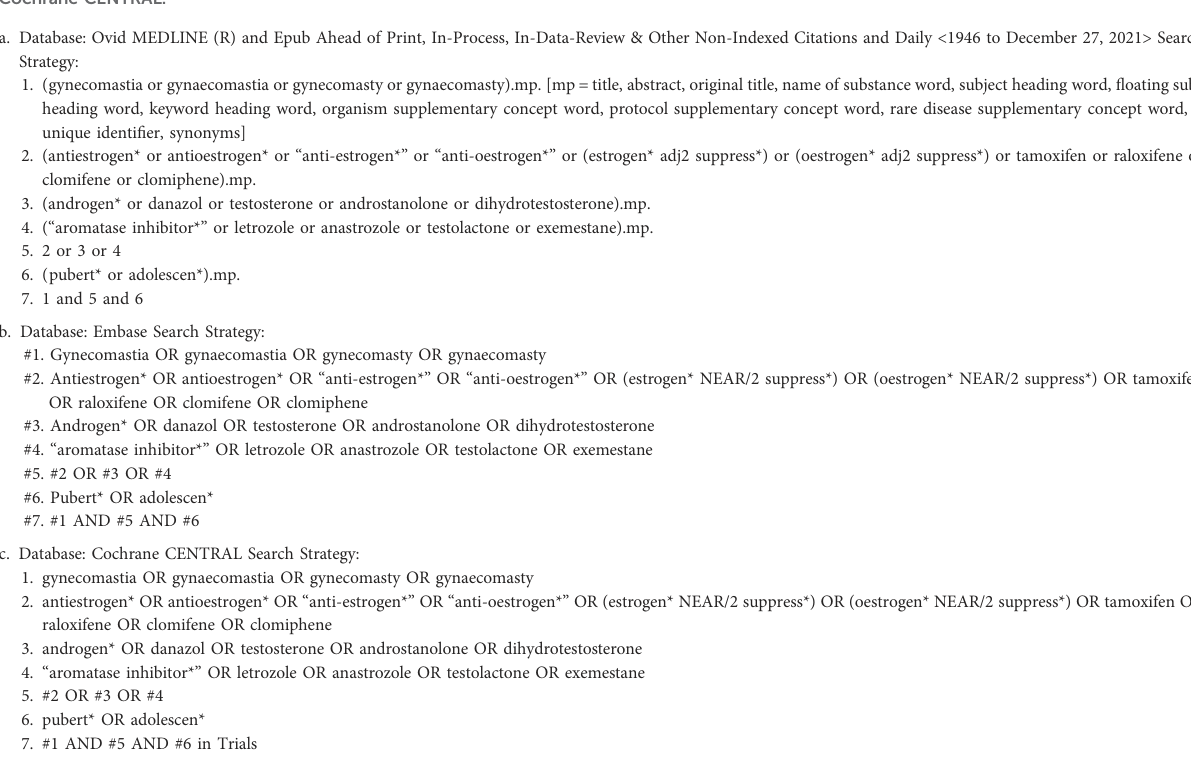
TABLE 1 Database search strategy, search algorithms and terms used to search in the different data bases: (a) Ovid MEDLINE, (b) Embase, and (c) Cochrane